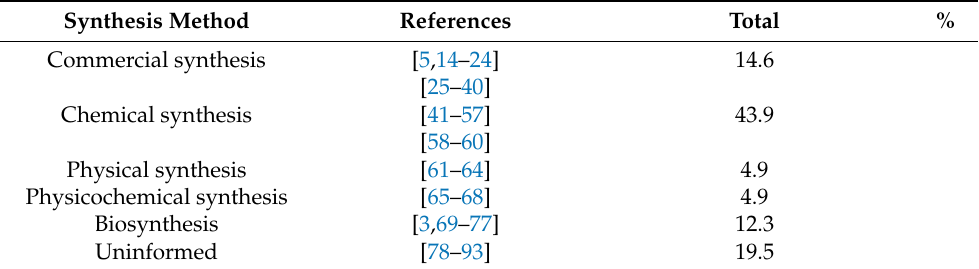
Table 1. Synthesis methods of silver nanoparticles used in dentistry. Synthesis